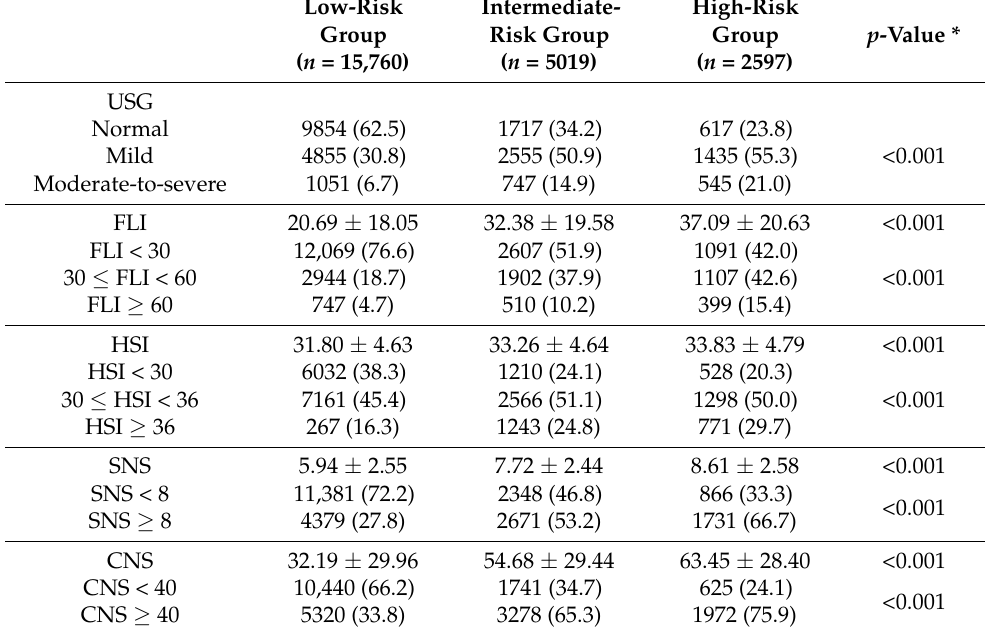
Table 2. Association between ultrasonographic grading of steatosis and the Fatty Liver Index (FLI), Hepatic Steatosis Index (HSI), Simple NAFLD Score (SNS), and Comprehensive NAFLD Score (CNS) according to cardiovascular risk